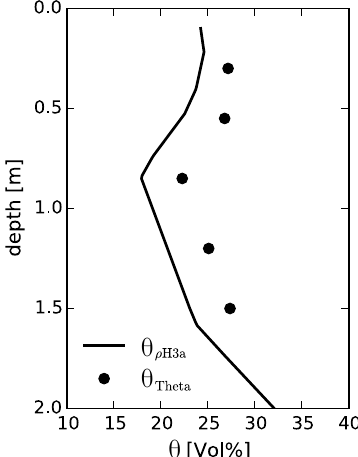
Figure 7. Volumetric water content calculated from resistivity data close to H3a in comparison with soil moisture sensors (date: 21 Oc- tober